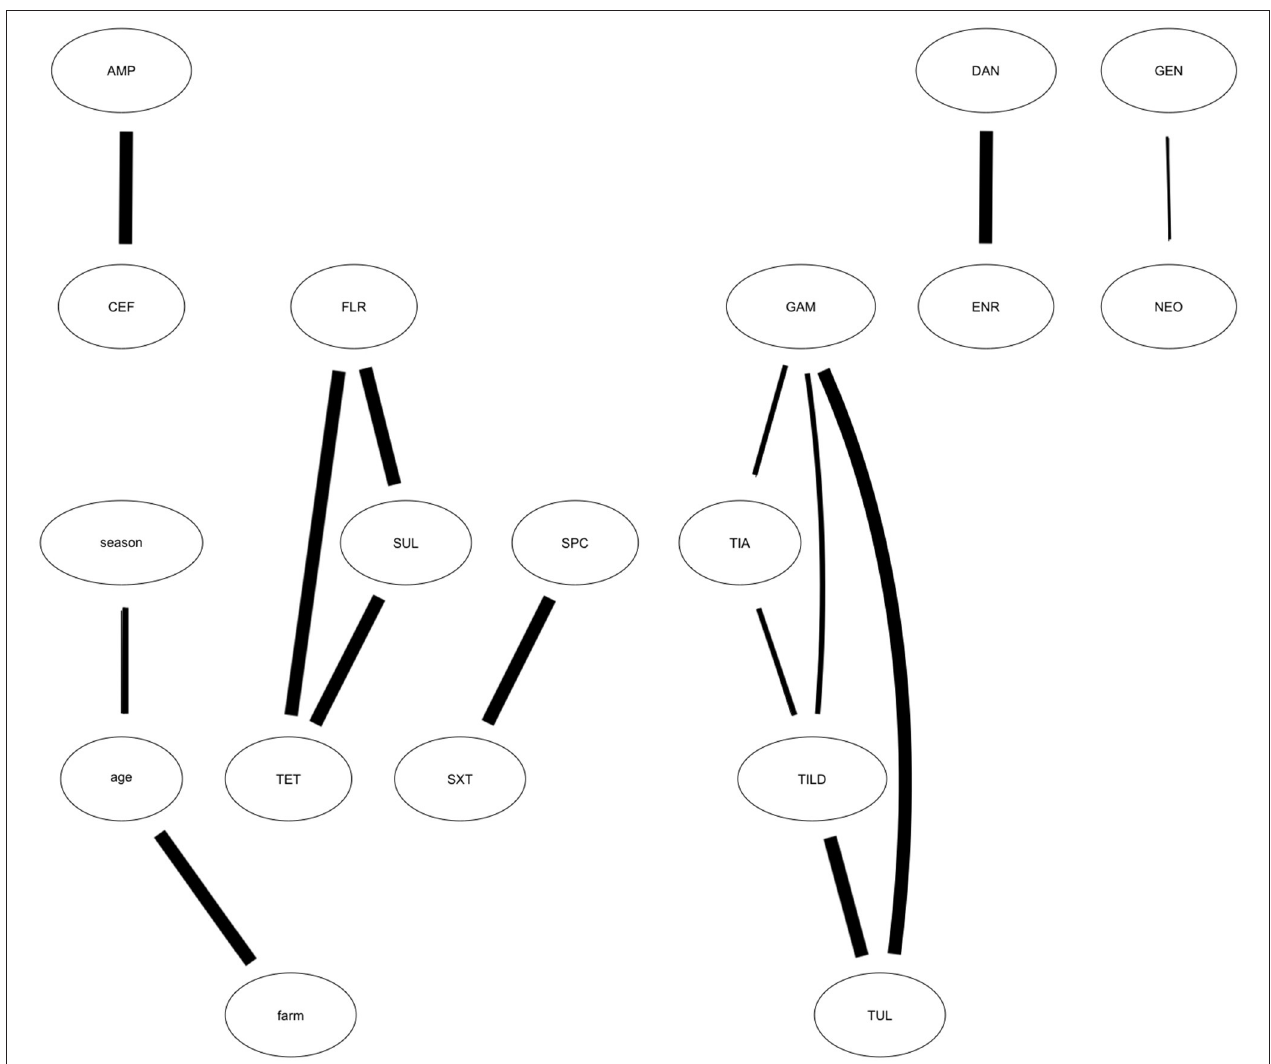
FIGURE 3 | Averaged, Consensus network model showing results of bootstrapped analysis. Averaged, consensus network developed from the optimal network showing the relationships among antibiotic MIC trends. The averaged, consensus network depicts the arcs identified from the optimal network that appear in more than 50% of the 10,000 bootstrapped samples and are most strongly supported by the data. Strength of connection is denoted by arc weight (i.e., the thicker the arc, the greater strength). Antibiotics represented in each node include: CEF, Ceftiofur; AMP, Ampicillin; TIA, Tiamulin; TUL, Tulathromycin; TILD, Tildipirosin; TET, Tetracycline; GEN, Gentamicin; NEO, Neomycin; GAM, Gamithromycin; FLR, Florfenicol; DAN, Danofloxacin; ENR, Enrofloxacin; SUL, Sulphadimethoxine; SXT, Trimethoprim-Sulfamethoxazole; SPC,